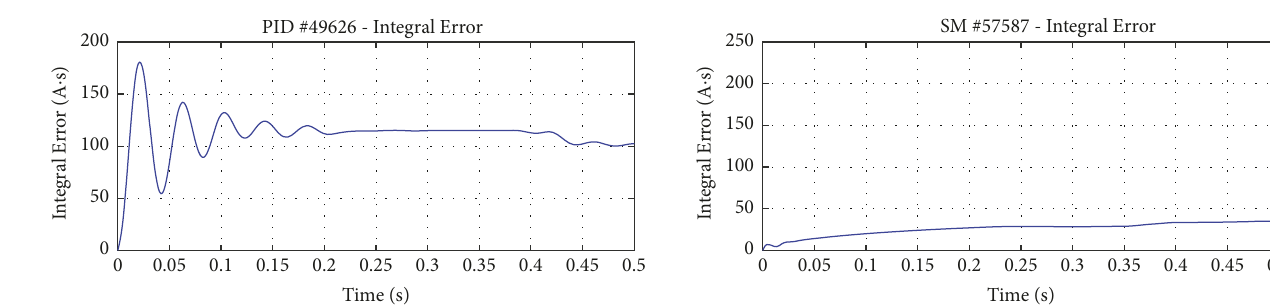
Figure 11: PID integral error (Shot #49626).